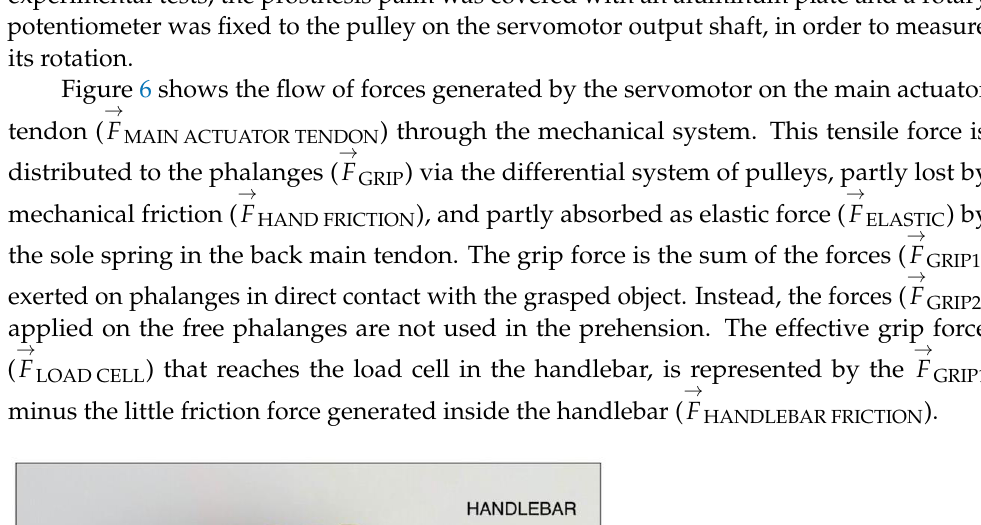
Figure 6. Diagram illustrating the flow of the force generated by the servomotor of the “Federica” hand. The Force Transfer Ratio was computed as the ratio between the force developed by the hand on the handlebar ( F⃗ LOAD CELL ) and the pulling force applied on the main actuator tendon ( F⃗ MAIN ACTUATOR TENDON ) , that is: 𝐹𝑜𝑟𝑐𝑒 𝑇𝑟𝑎𝑛𝑠𝑓𝑒𝑟 𝑅𝑎𝑡𝑖𝑜 =